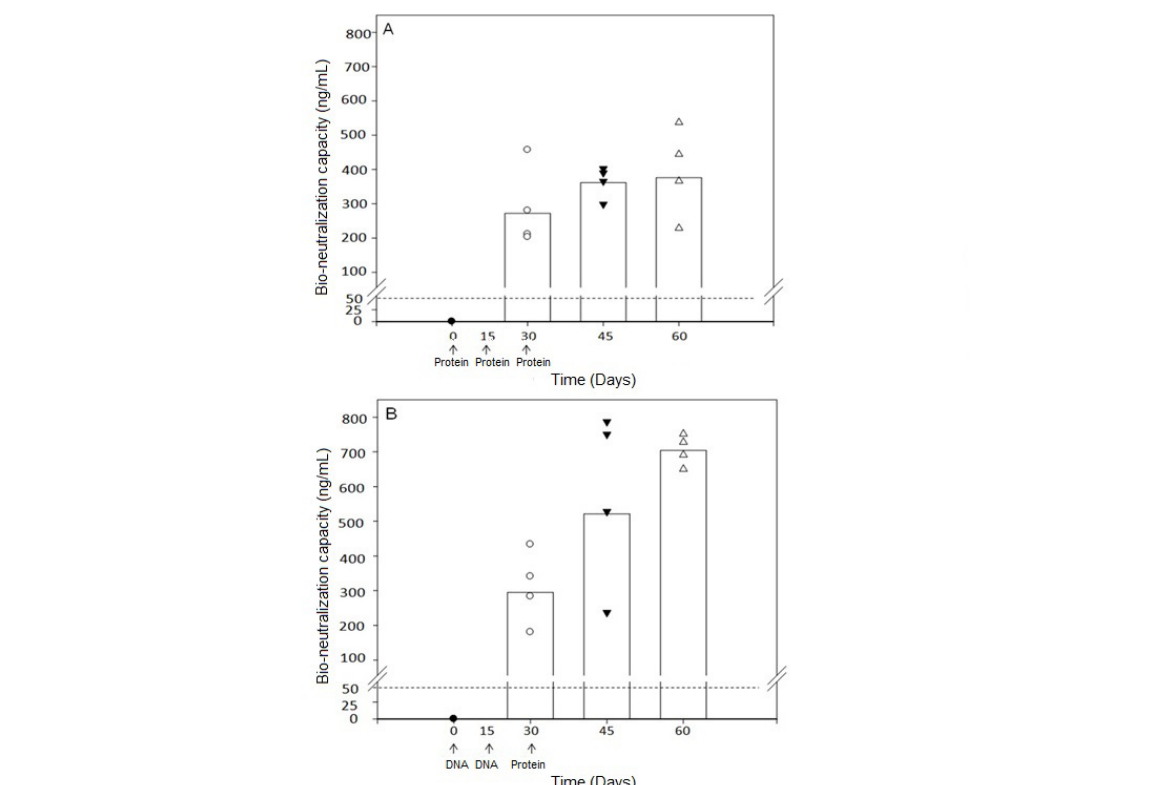
Figure 5. Bioneutralization capacity of anti-hCG antibodies. (A) Immunization with protein form of the vaccine for the three primary injections; (B) immunization with DNA form of the vaccine for the first two injections followed by protein form of the vaccine. A dotted line of 50 ng/mL is the protective threshold of antibodies for preventing pregnancy in humans Note. Reprinted from “Priming with DNA enhances considerably the immunogenicity of hCG β-LTB vaccine” by Nand KN, Gupta JC, Panda AK, Jain SK, Talwar GP. Am J Reprod Immunol. 2015;74:302-8 (https://doi.org/10.1111/aji.12388). © 2014